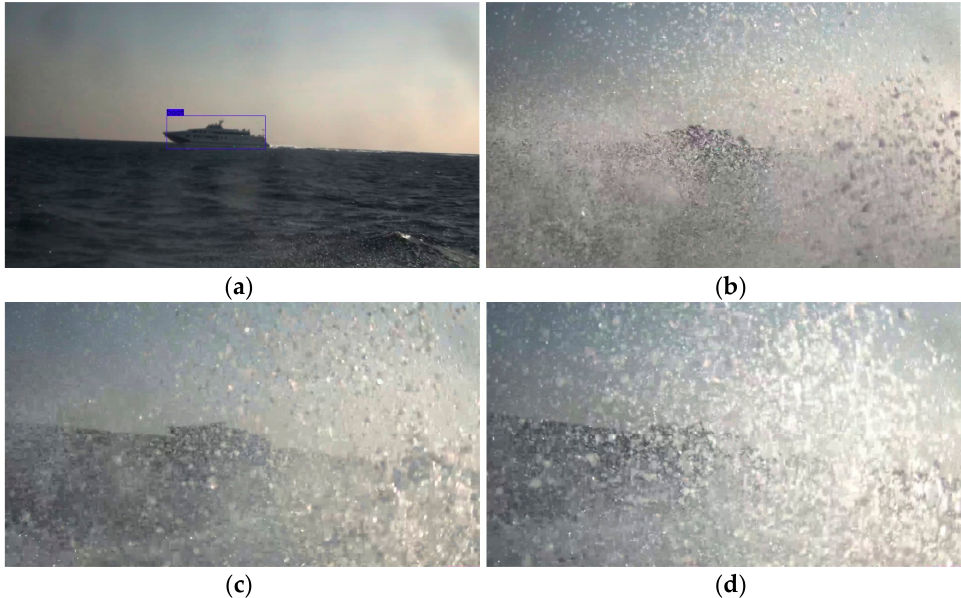
Figure 11. Images of the green-water scene: ( a ) A scene before the object is obscured; ( b ) The scene 1 where the object is obscured; ( c ) The scene 2 where the object is obscured; ( d ) The scene 3 where the object is obscured.